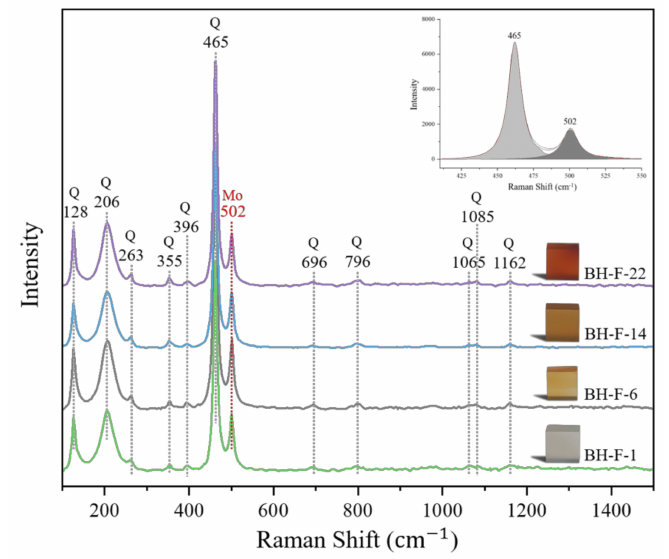
Figure 4. Representative Raman spectra of the silica matrix of Beihong agates. The Gaussian Lorentzian fit for the 465 cm − 1 (Q) and 502 cm − 1 (Mo) bands are shown in the upper right